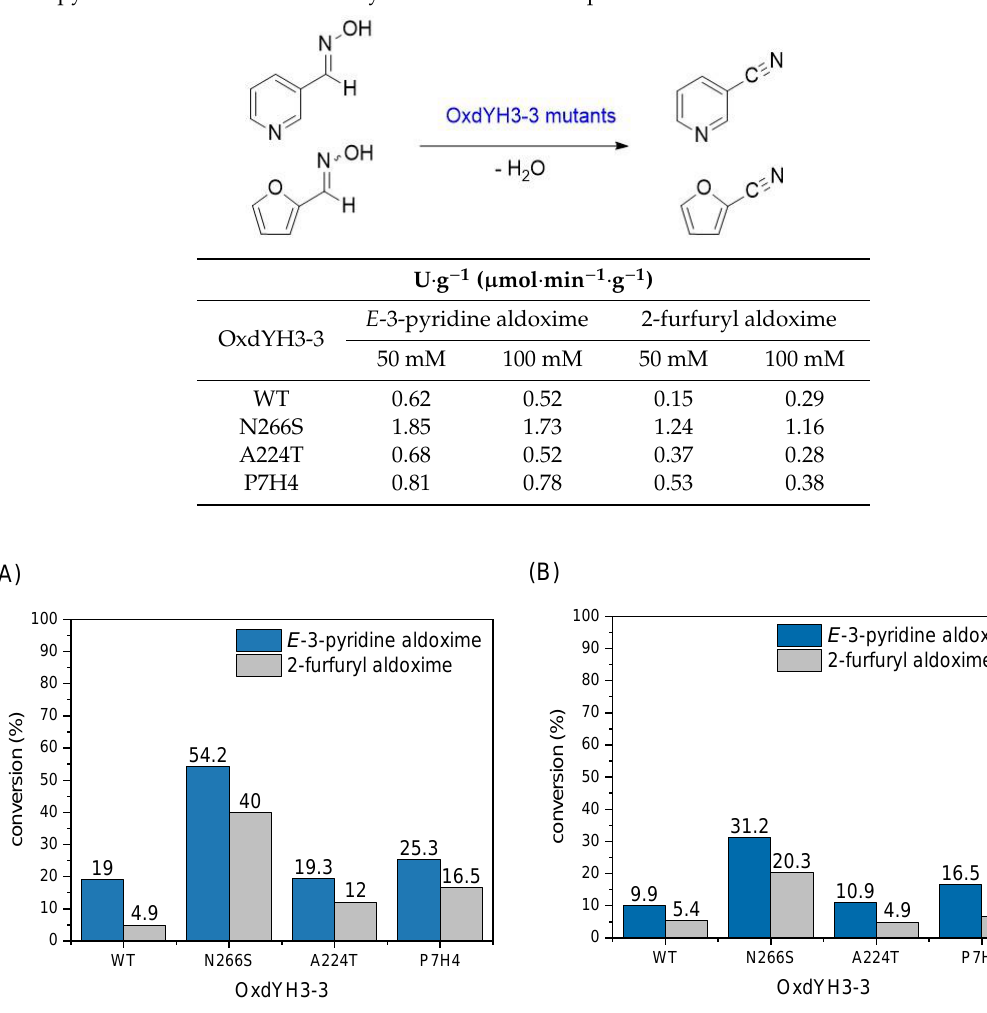
Table 1. The activity of OxdYH3-3 WT and mutants. The activities at 1 h toward 50 and 100 mM of E - 3-pyridine aldoxime and 2-furfuryl aldoxime were compared.